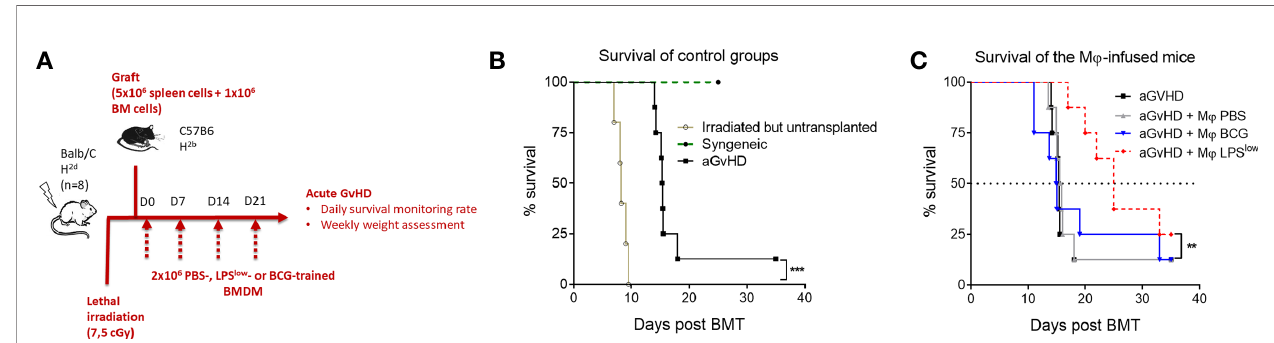
FIGURE 6 | Weekly infusion of LPS low -trained macrophages alleviates acute murine GvHD. (A) Schematic representation of the in vivo induction of MHC- mismatched acute GvHD and scheduling of trained macrophages infusion. Mice (n = 8 per group) from one experiment were monitored for survival. (B) Kaplan – Meier survival curve of the control groups of the acute GvHD experiment showing the survival rate of syngeneic, irradiated, but untransplanted and aGvHD mice. (C) Survival rate of the different groups of the experiment. Each group: aGvHD, aGvHD + M j PBS, aGvHD + M j BCG, aGvHD + M j LPS low contained (n = 8) mice. Statistics are shown between the non-treated aGvHD and the aGvHD + M j LPS low group. The log-rank (Mantel – Cox) and the Gehan – Breslow – Wilcoxon statistic tests were used to detect the differences between the groups. NS, non-signi fi cant; **p ≤ 0.01; ***p